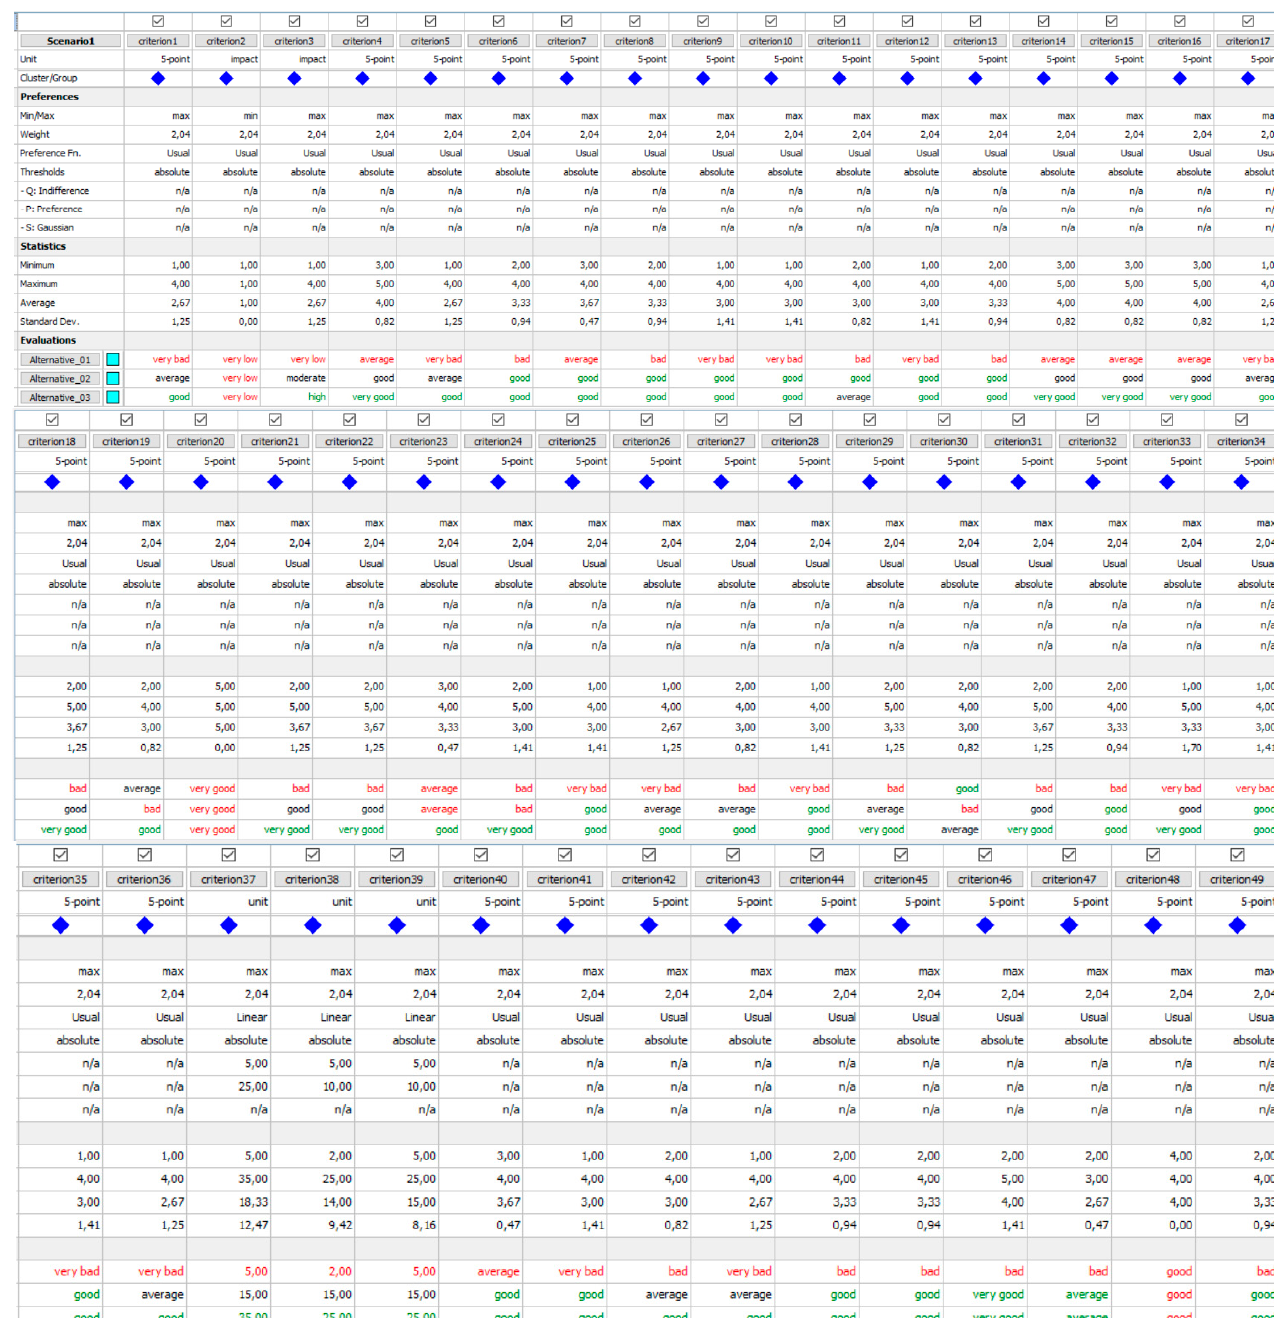
Figure A2. Decision matrix from VisualPROMETHEE.